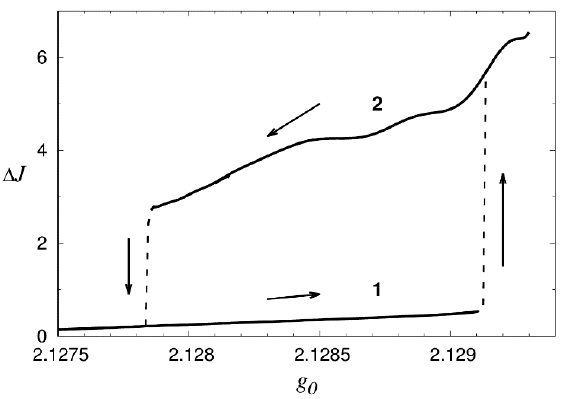
Figure 15. Hysteretic dependence of difference of two main inertia moments of “apple” laser solitons with the same topology. In state 1 soliton has fixed “solid-like” structure, whereas it is more asymmetric and oscillates in state 2.